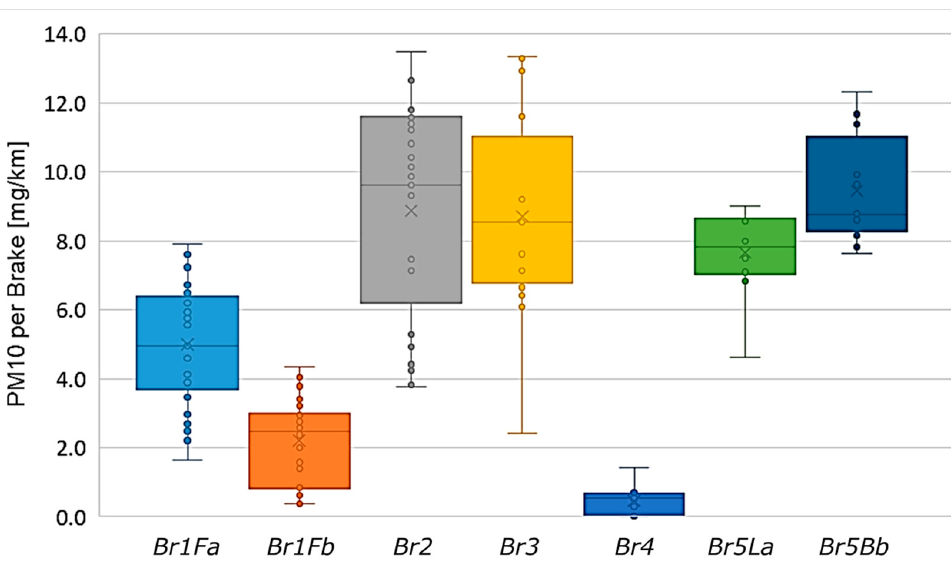
Figure 2. Overview of the PM10 measurement results for all brakes. The minimum, first quartile, median (denoted with the horizontal line), average (denoted with the “×”), third quartile, and maximum statistical variables are included in the chart. No outliers were detected.